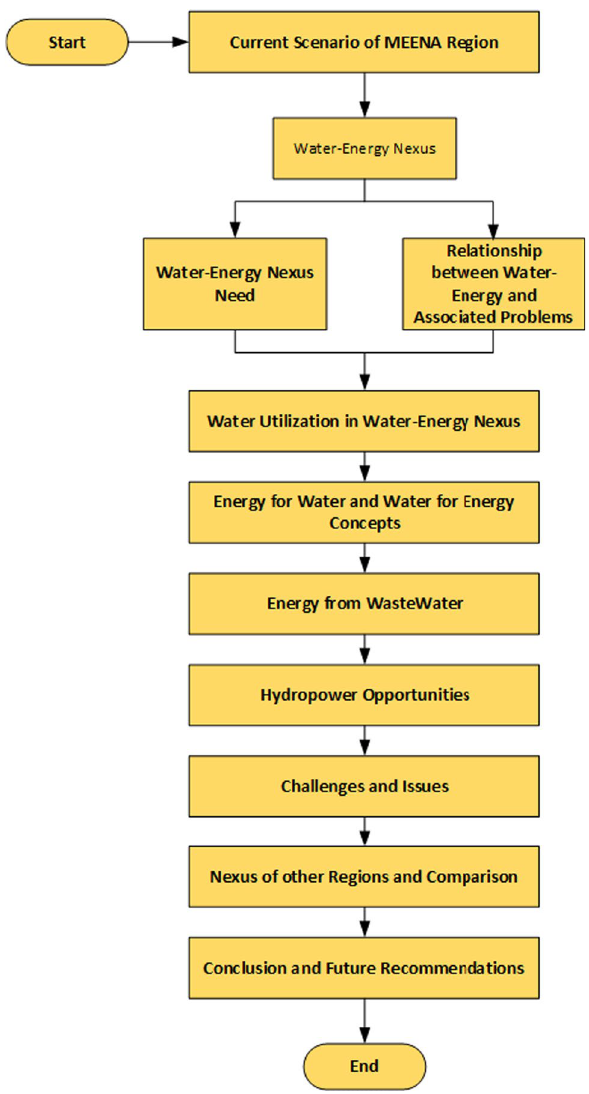
Fig. 2 Flowchart diagram for adopted methodology for